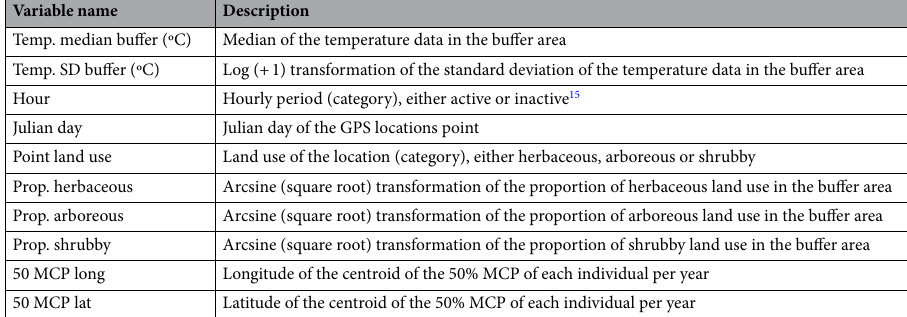
Table 2. Explanatory variables used in the models of microclimate refugia availability and use, for both breeding and post-breeding